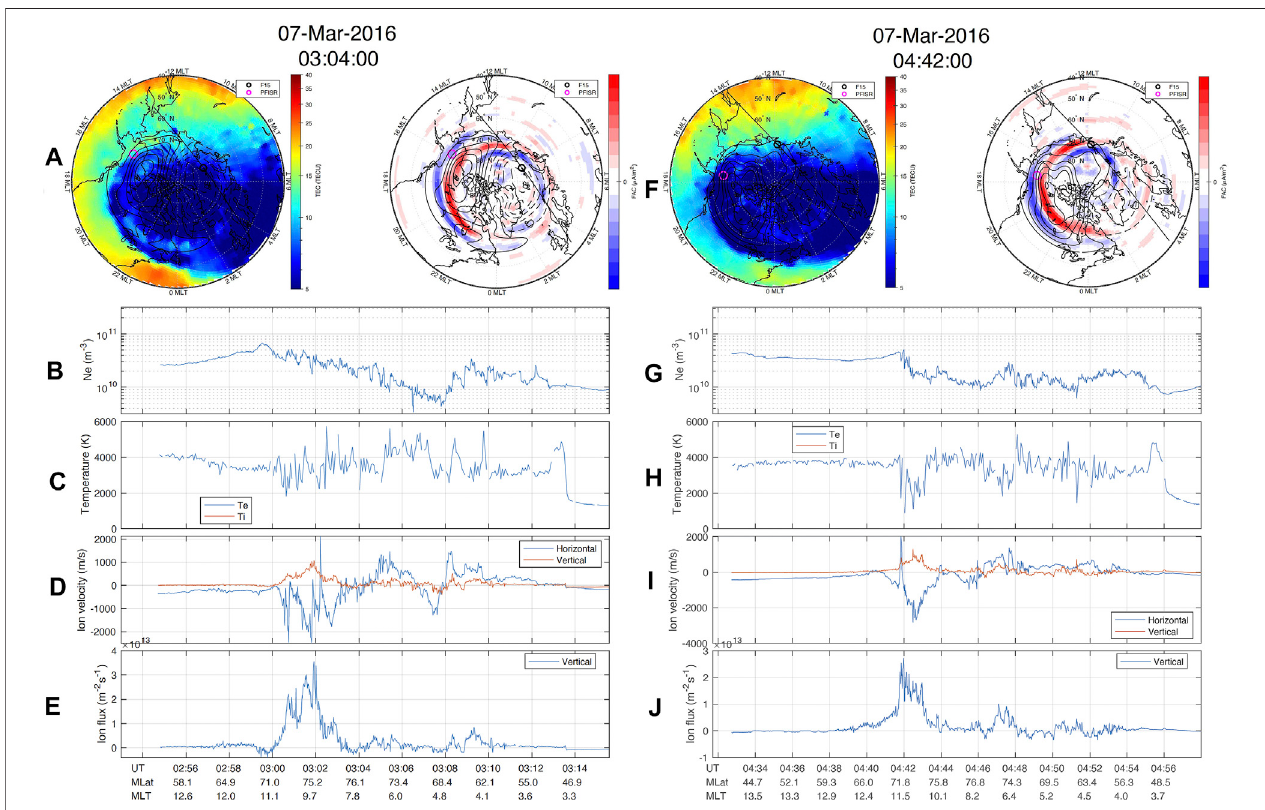
FIGURE 8 | The same format as Figure 7 but during the ionospheric negative storm